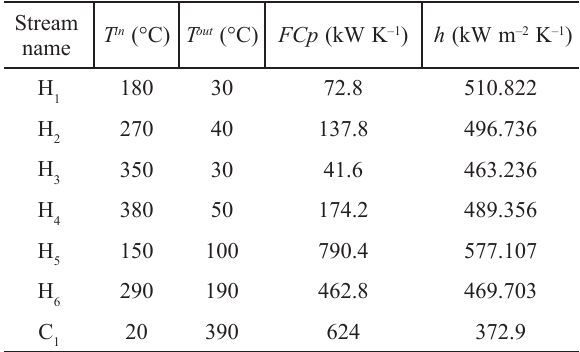
Table 6 – Thermodynamic data for case study two